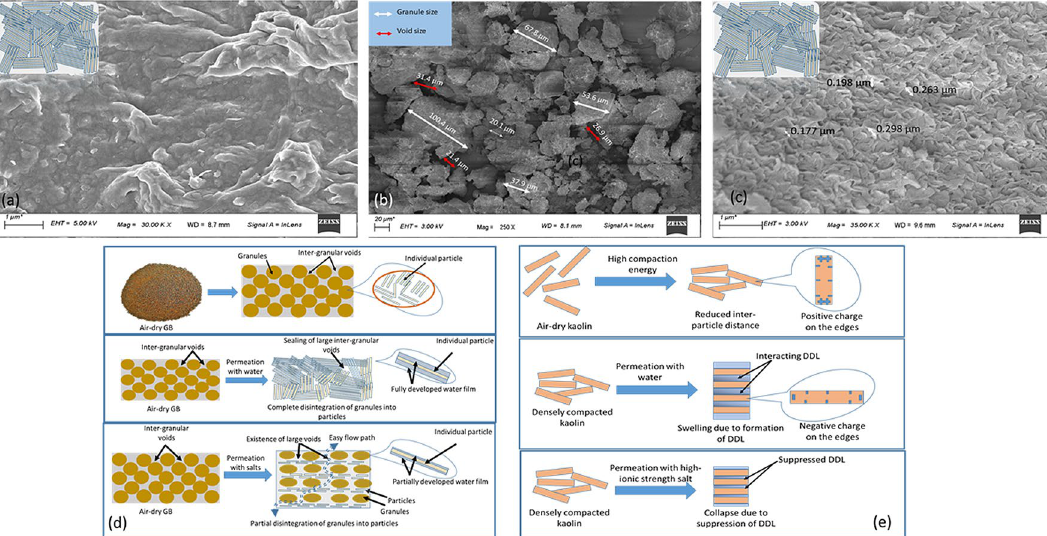
Figure 6. FESEM image of GB as individual layer ( a ) in the presence of water, ( b ) in the presence of 0.5 M KCl, ( c ) FESEM image of the GB of the kaolin-GB layered system upon permeation with 0.5 M KCl, ( d ) illustration depicting complete and partial disintegration of the granules into particles in the presence of water and salts, respectively ( e ) particle orientation of kaolin in the presence of water and high-ionic strength salt